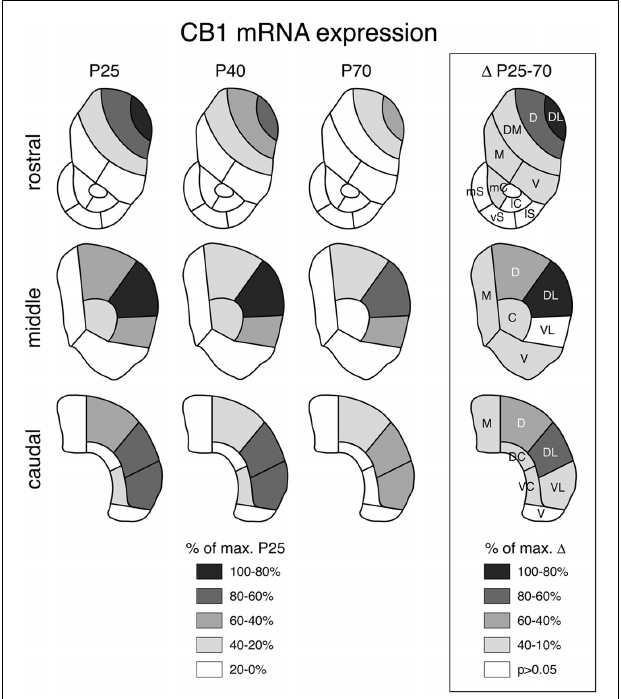
FIGURE 3 |Topography of striatal CB1 receptor expression at different postnatal ages and decreases in expression between juvenile and adult rats. Maps depict the distribution of CB1 mRNA in the rostral, middle, and caudal striatum in juveniles (P25), adolescents (P40) and adults (P70) (left) and the differences in expression between P25 and P70 animals (boxed; right).The data are normalized relative to the maximal value at P25 (left) or the maximal difference (right) (% of max.), and the values and significant decreases ( P < 0.05) are coded as indicated. Abbreviations: caudate–putamen: C, central; D, dorsal; DC, dorsal central; DL, dorsolateral; DM, dorsomedial; M, medial;V, ventral;VC, ventral central;VL, ventrolateral; nucleus accumbens: mC, medial core; lC, lateral core; mS, medial shell; vS, ventral shell; lS, lateral shell. revealed three different clusters in the value distribution, indi-